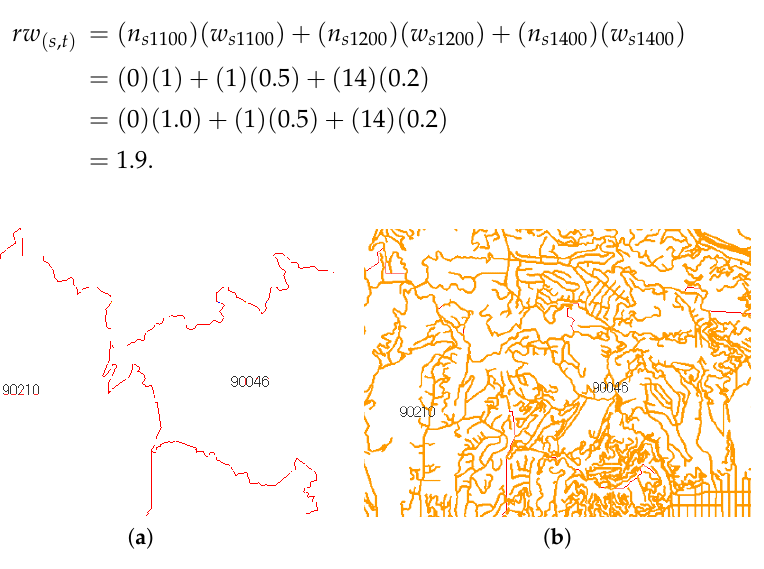
Figure 10. Roads in adjacent areas of 90210 and 90046. ( a ) plain adjacent ZIP code; ( b ) adjacent ZIP code with road